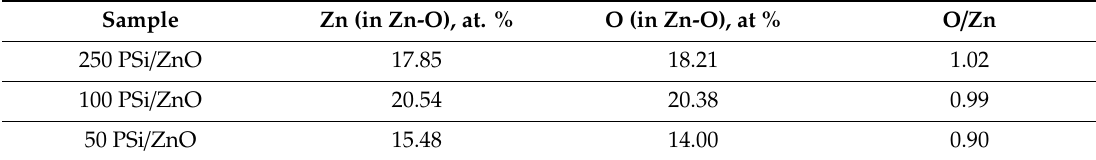
Table 1. ZnO layer